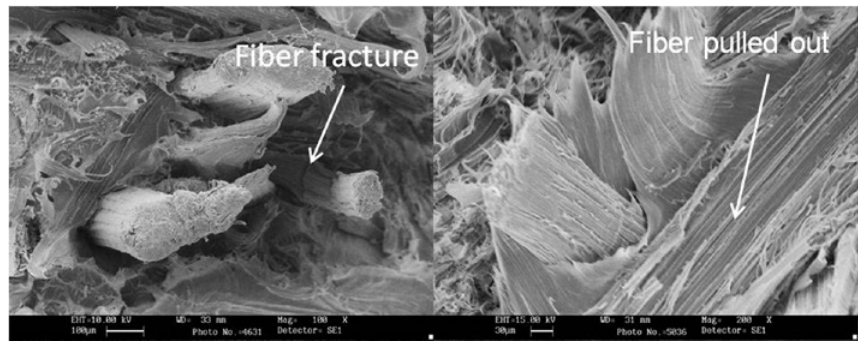
Figure 9: SEM micrograph of the tensile fracture surface of sample S1 at × 100 and × 200 magnification.